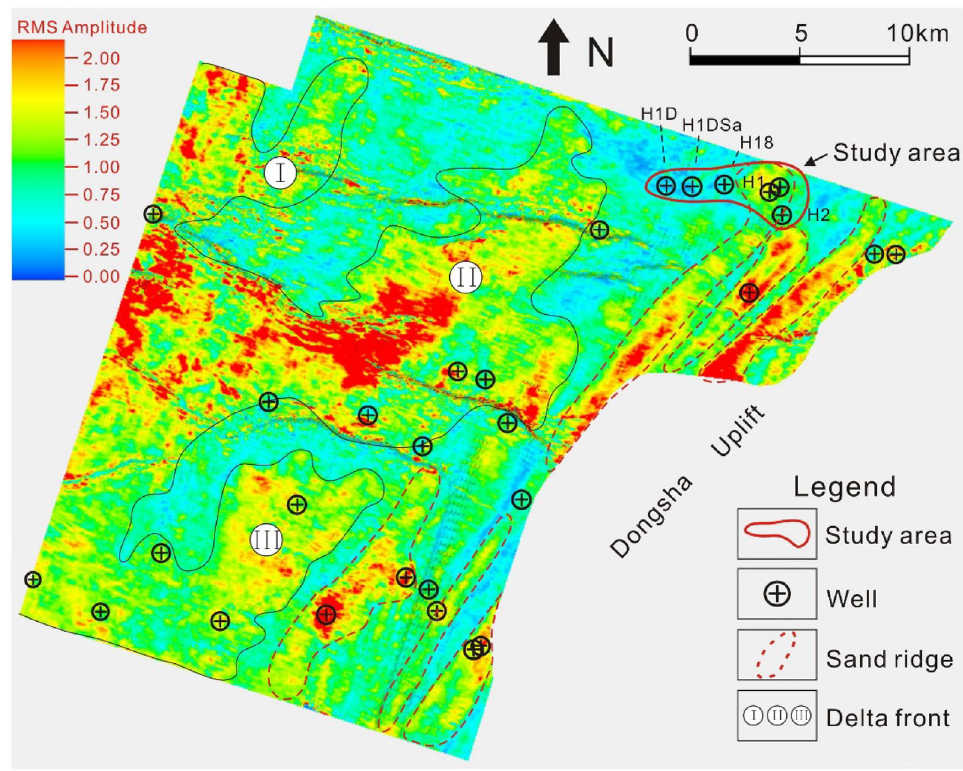
Figure 4. Seismic distribution model sandstone and mudstone of K22 layer, obtained from geostatistical inversion (After CNOOC) 14 . This inversion profile is based on high-resolution seismic data and logging data. The stochastic obvious distinctions presented by different values indicate clustering of sandstone (high values) and mudstone (low